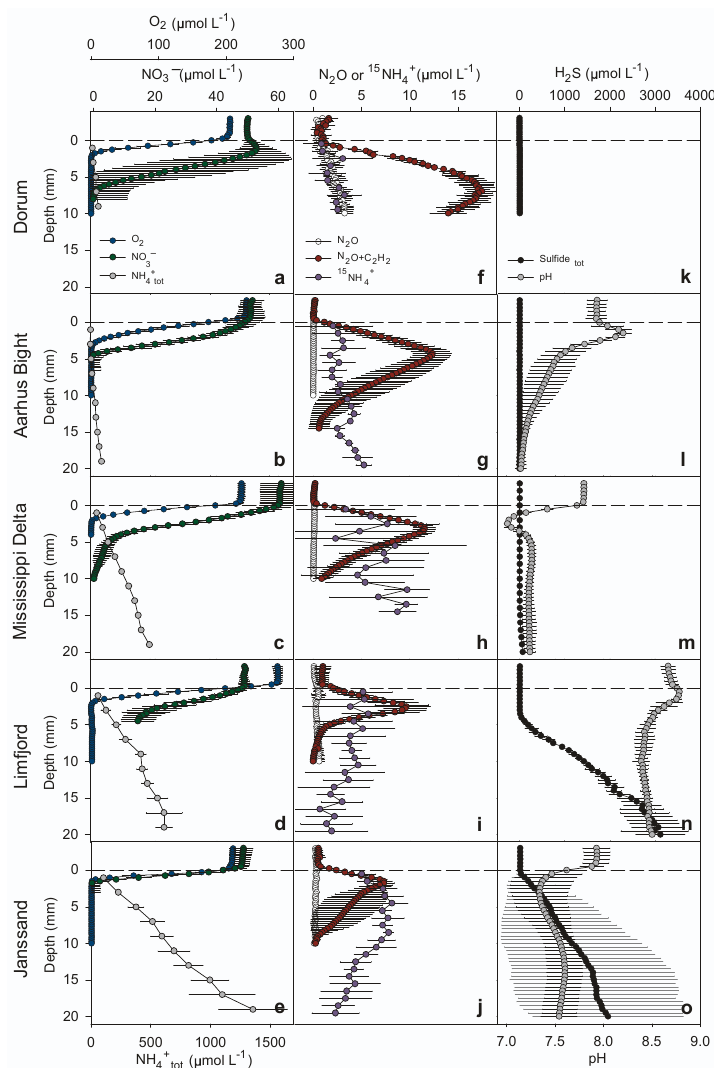
Fig. 1. Vertical profiles of O 2 , NO − and NH + (a–e) , 15 NH + and N 2 O (f–j) and pH and Sulfide tot (k–o) measured in intact sediment cores 3 4 4 from different coastal marine sampling sites. The NH + profiles were measured in extracted pore water, 15 NH + 4 activity) were measured with gel probes, while the other profiles were measured with microsensors. The DEN activity profiles (represented by the N 2 O profiles with acetylene) were measured after inhibition of the last step of denitrification with acetylene. Means ± standard deviation of 3–9 profiles are